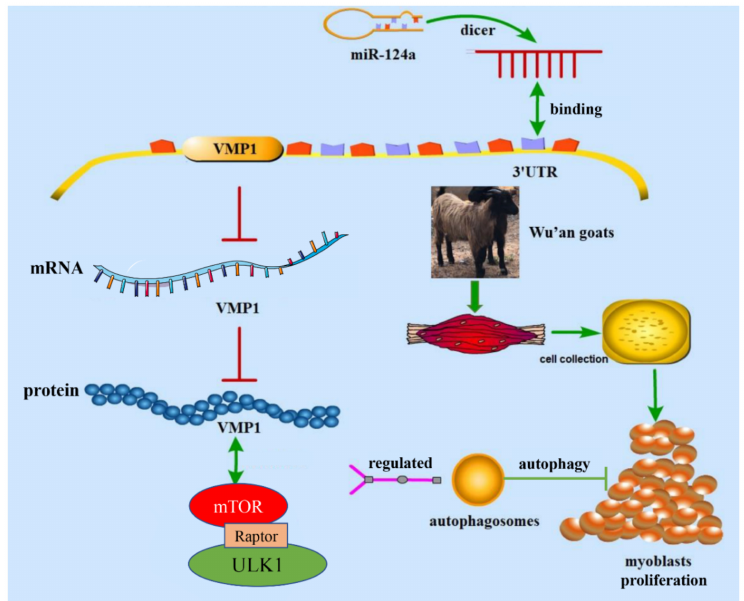
Figure 11. Flowchart of the effects of VMP1 regulated by miR-124a on the proliferation, autophagy, and apoptosis of goat myoblasts through the PI3K/AKT/mTOR signaling